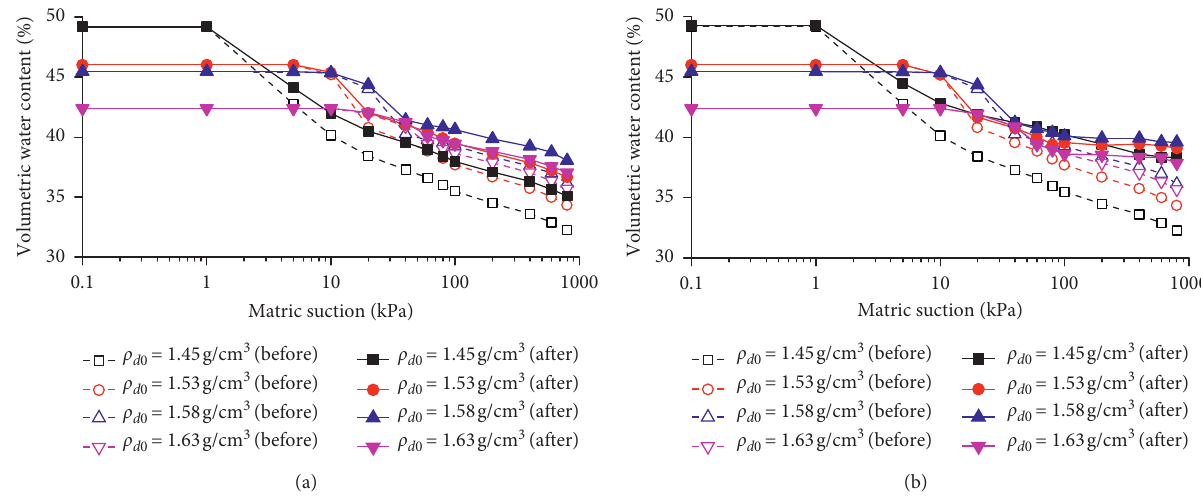
Figure 18: Relationships between volumetric water content and matrix suction after correction (a) based on the shrinkage test and (b) based on the centrifuge